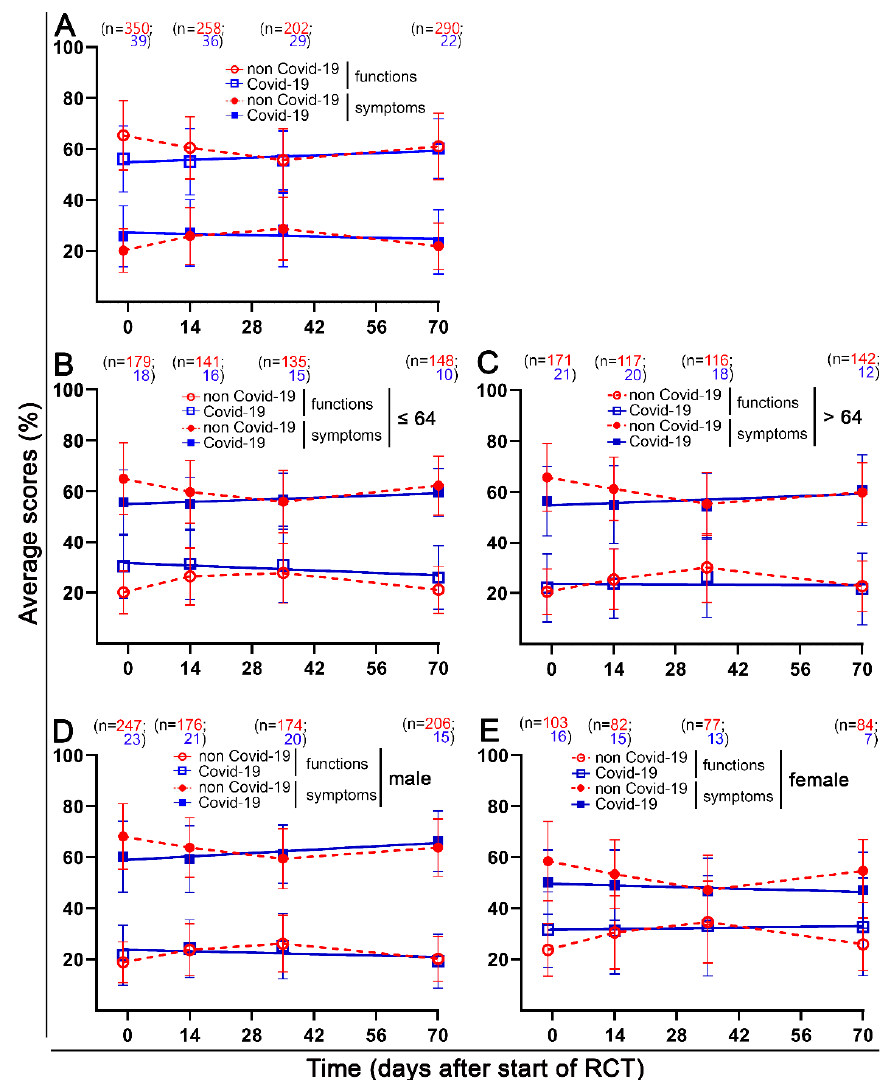
Figure 5. Time course of different functional and symptom scores, the functional and symptom scores for the two age groups (age <64 and age >64), and two sexes (male and female) at day 1, day 14, day 35, and day 70 at pre-pandemic times and pandemic times. ( A ) The general functions and symptoms for both the pre-pandemic and pandemic periods. ( B ) The young age cohort ≤ 64 years compared to the older age cohort ( C ) >64 years before the pandemic and in the pandemic period. ( D ) Males compared to ( E ) females before the pandemic and in the pandemic period. Error bars indicate the standard deviation.